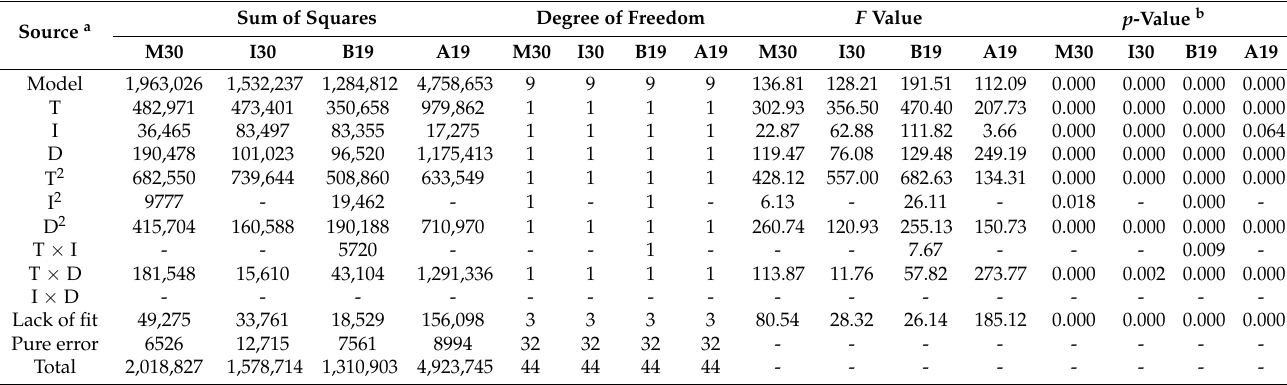
Table 2. Response surface quadratic model analysis of HPL activity level obtained with M30, I30, B19 and A19 expression system, after model simplification—analysis of variance